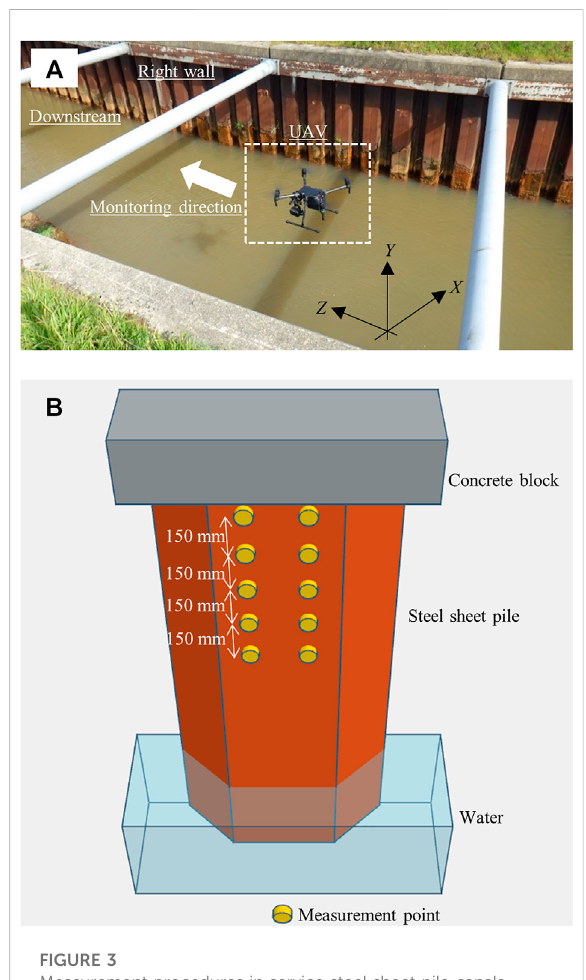
FIGURE 3 Measurement procedures in service steel sheet pile